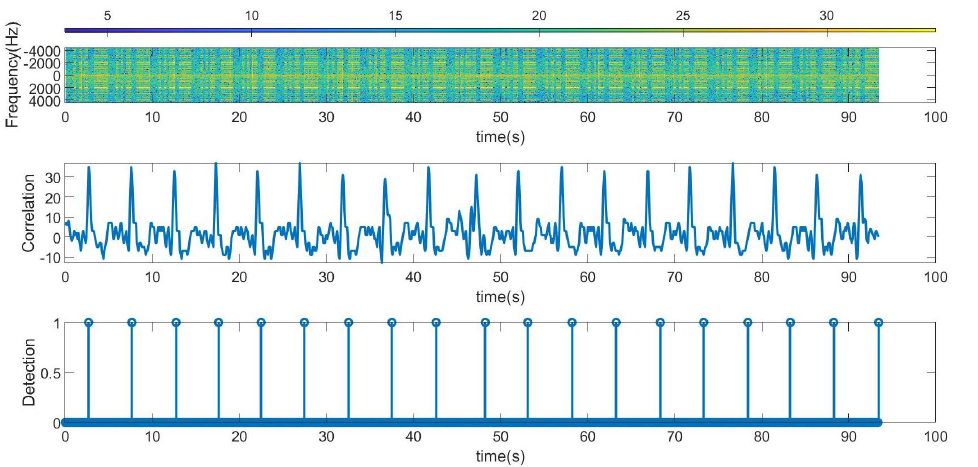
Figure 17. Measurement for a stationary scooter sending Barker codes of length 13 at a distance of 8 m. From top to bottom: raw spectrogram before the CFAR processor, the signal at the output of the correlator and tag